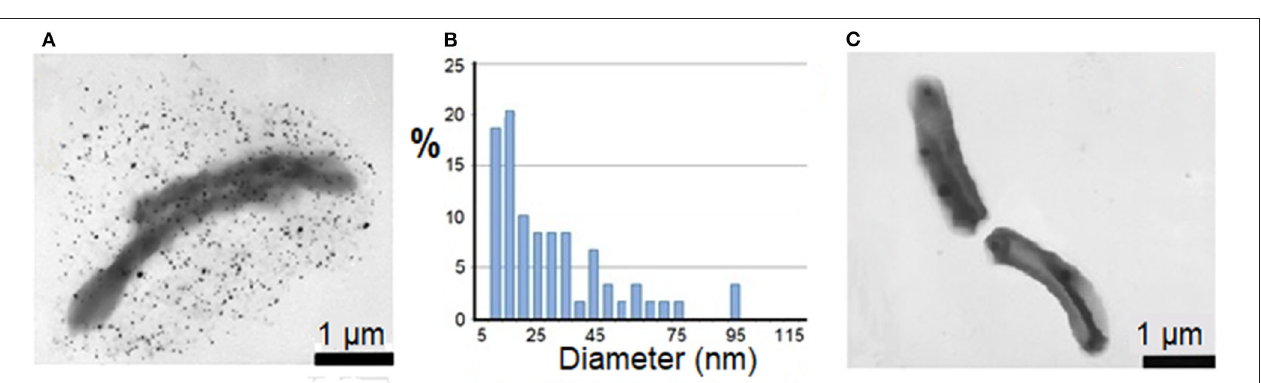
FIGURE 3 | Distribution in sizes (B) of biogenic Ag ◦ NPs generated by psychroactive Cryobacterium sp. 1639 at + 5 ◦ C in 20min (A) . No Ag ◦ NPs generated by cells Cryobacterium sp. 1639 at + 24 ◦ C (C) .